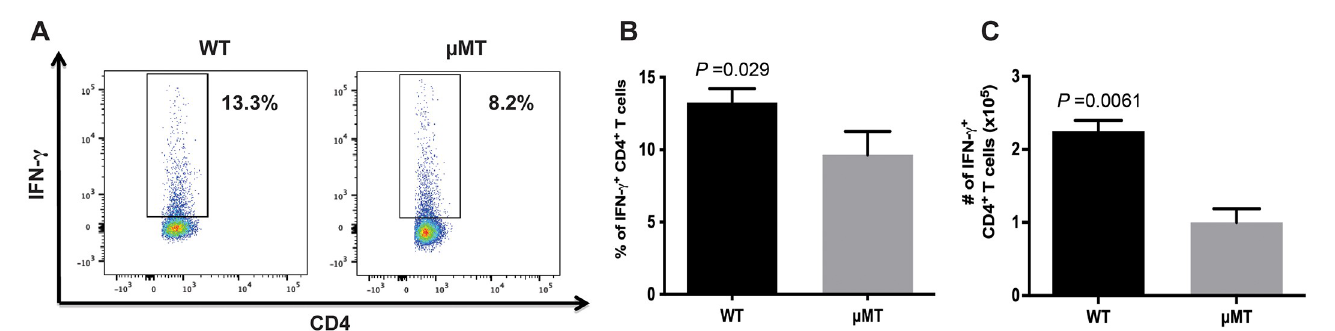
Fig 3. B cell-deficient μ MT mice exhibit diminished levels of IFN- γ -producing CD4 + T cells during chronic TB. Mice were infected with 100 CFU of M . tuberculosis Erdman by aerosolization. (A) Representative frequencies of IFN- γ + CD4 + T cells detected by flow cytometry at 5 months after infection; n = 4 mice per group. (B) Absolute number of lung IFN- γ + CD4 + T cells detected 5 months after infection; n = 4 mice per group. The results are expressed as mean ± SEM. Data in this figure is representative of 3 similar experiments. The data show revealed the B cell-deficient μ MT mice, relative to WT, display an attenuated Th1 response during the chronic phase of tuberculous